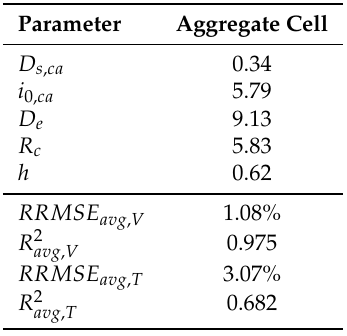
Table 9. Cycling calibration optimization results for the aggregate cell.